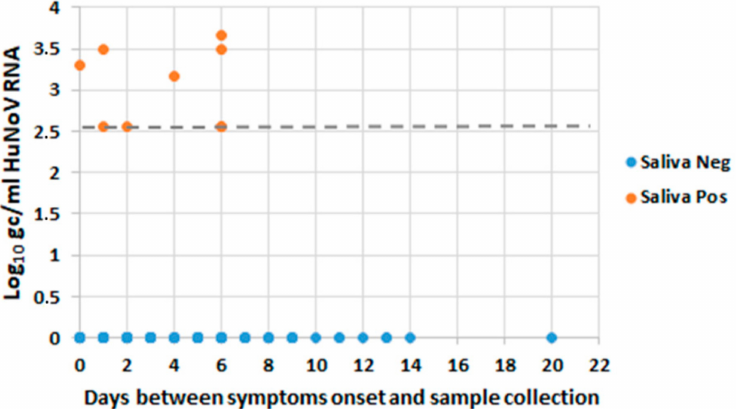
Figure 2. Individual HuNoV RNA titers according to time of sample collection for saliva-positive and saliva-negative subjects. Viral titers are expressed as log 10 genome copies / mL of saliva. Dashed line indicates limit of quantification (LOQ) of viral RNA in